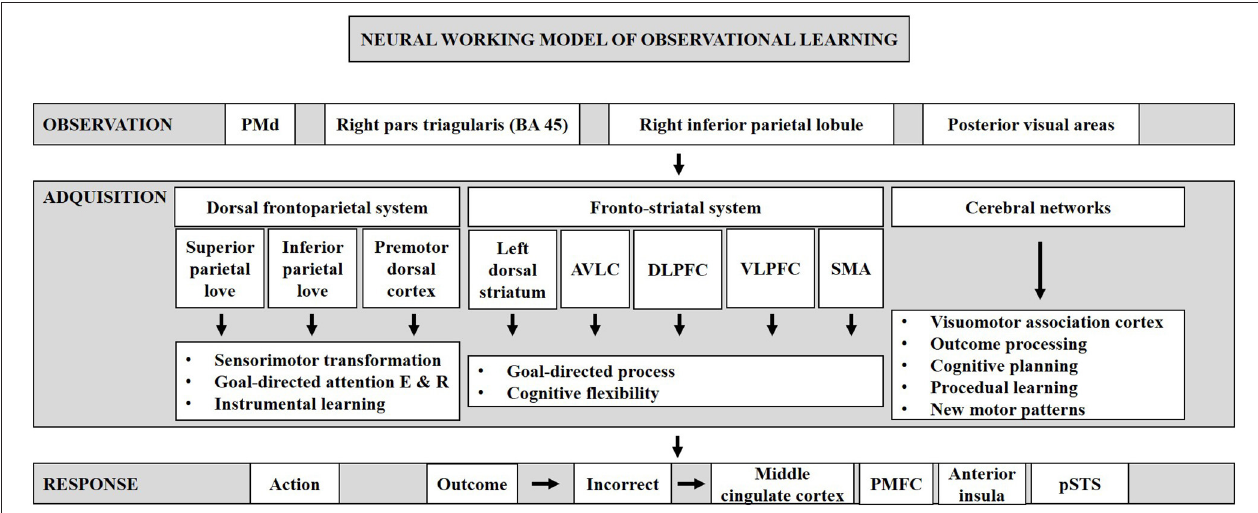
FIGURE 4 | Neural working model of observational learning. It can be divided into three phases: observation, acquisition, and